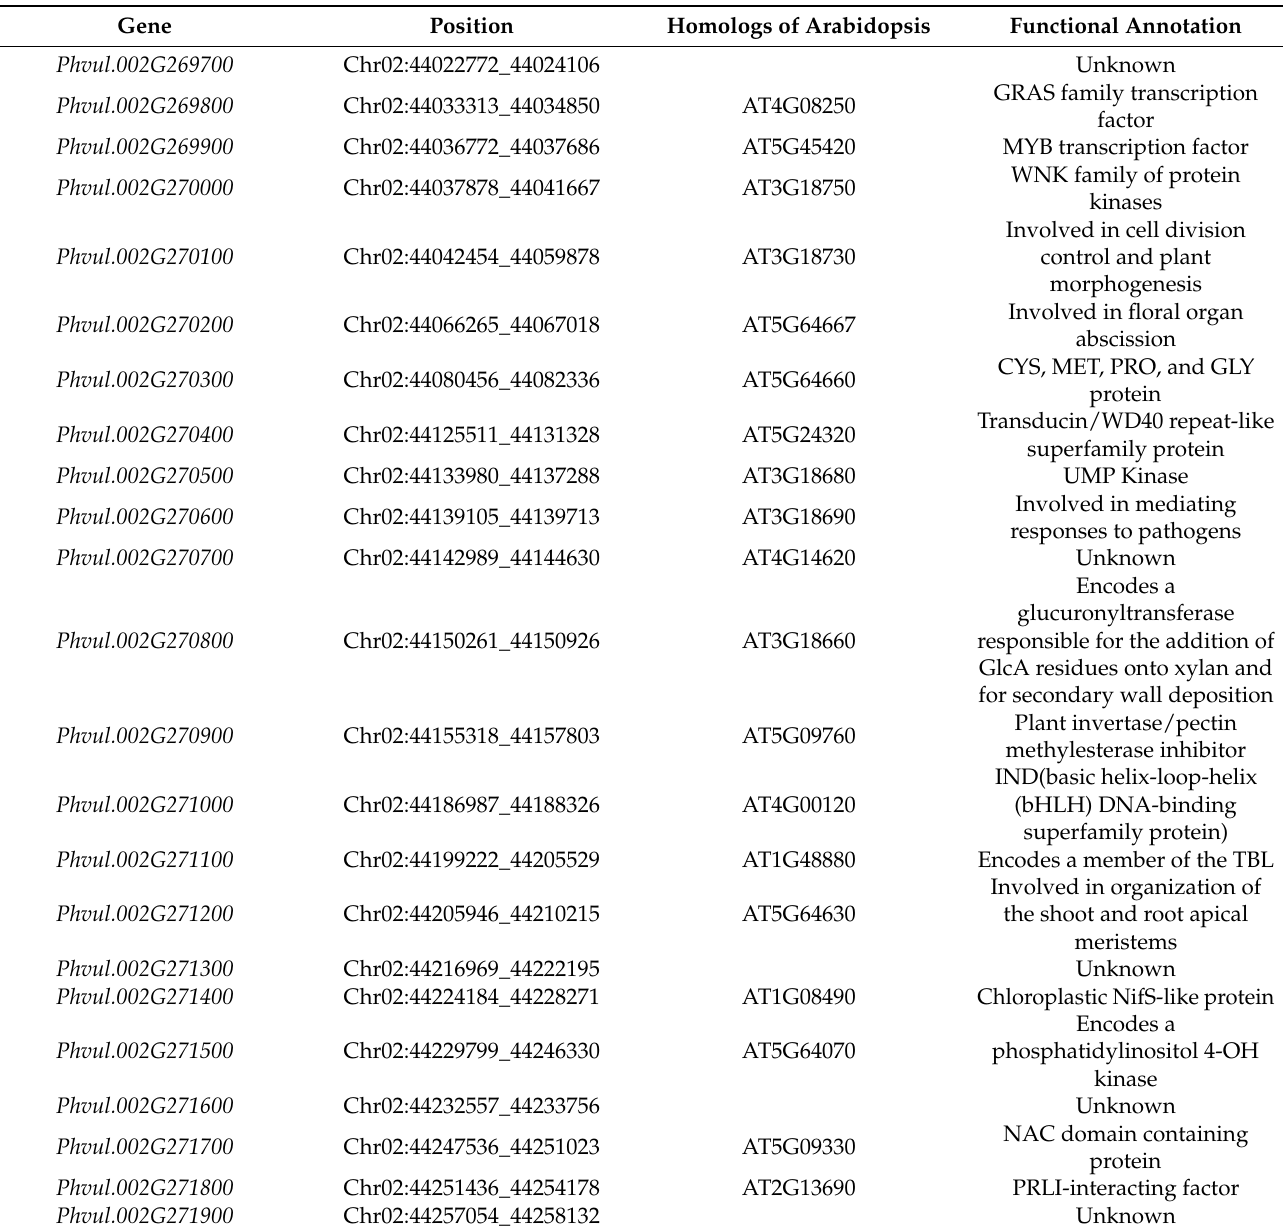
Table 1. Putative genes in the 266.19 kb of candidate